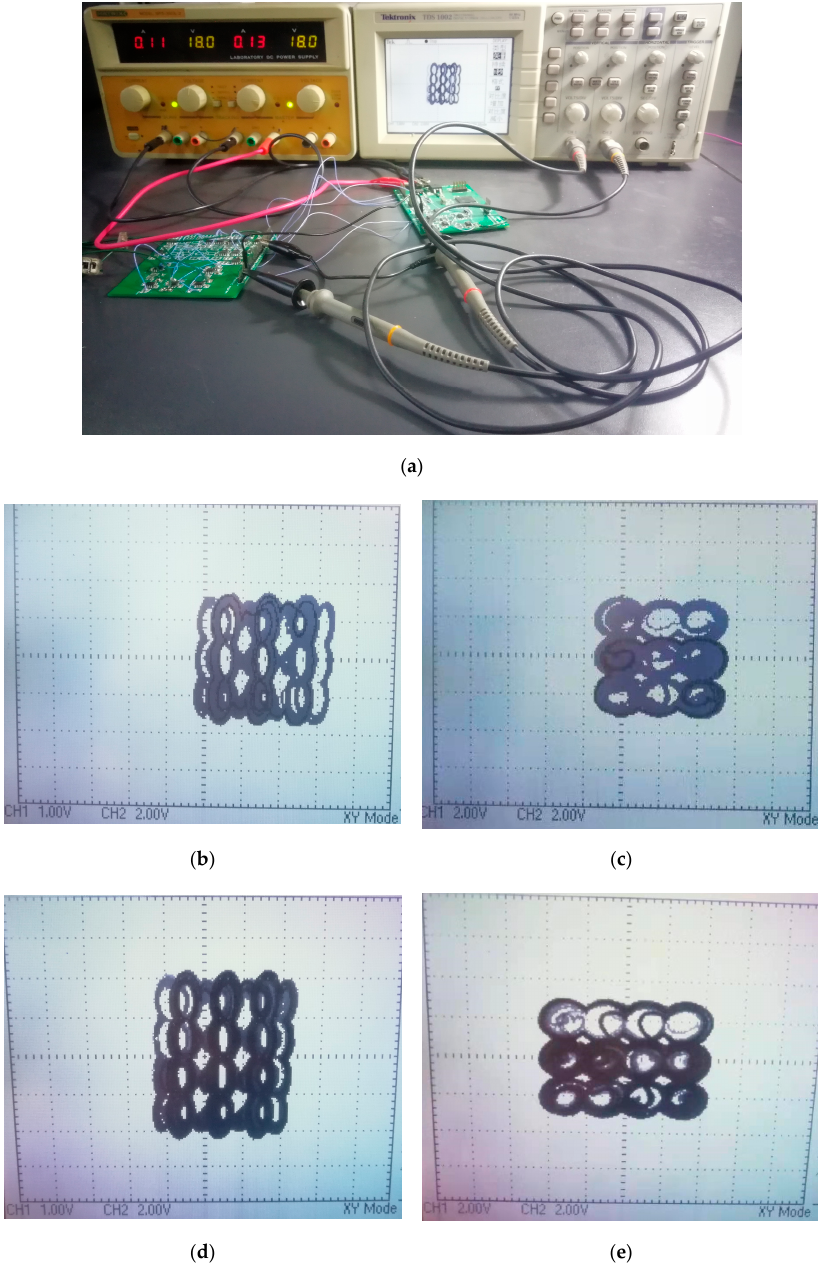
Figure 14. (Color online) The experimental verification of the proposed system: ( a ) the test system; ( b ) the experimental result of the 3 × 3 × 3-scroll in the x–y plane; ( c ) the experimental result of the 3 × 3 × 3-scroll in the y–z plane; ( d ) the experimental result of the 3 × 4 × 3-scroll in the x–y plane; and ( e ) the experimental result of the 3 × 4 × 3-scroll in the y–z plane.